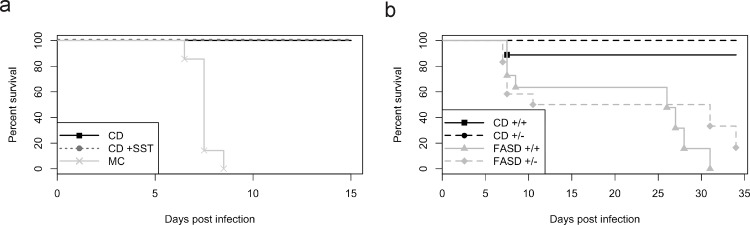
Survival of mice fed diets with variable folate content.(a) CD mice (n = 8) and CD+SST mice (n = 7) did not show differences in survival at 15 dpi (p = 1.0, log-rank test); MC mice (n = 7) had 100% mortality by 10 dpi. (b) Survival of CD+/+ mice (n = 9), CD+/- mice (n = 14), FASD+/+ mice (n = 11), and FASD+/- mice (n = 12) in two experiments combined. Mice fed CD had a greater chance of surviving infection than mice fed FASD (p<0.01, Cox proportional hazards). Mthfr genotype had no effect on chance of survival in mice fed CD or FASD (p = 0.45, Cox proportional hazards).